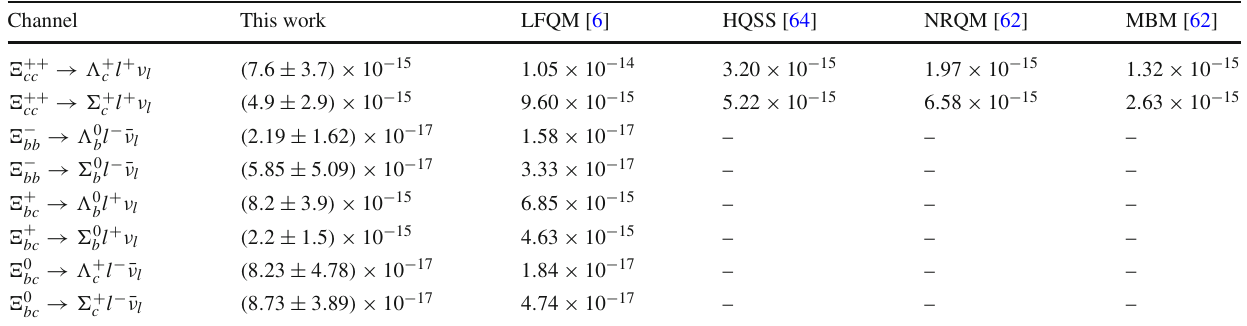
Table 19 The decay widths (in units of GeV) for the semileptonic decays obtained in this work are compared with those from the light-front quark model (LFQM) [6], the heavy quark spin symmetry Channel This work LFQM [6]